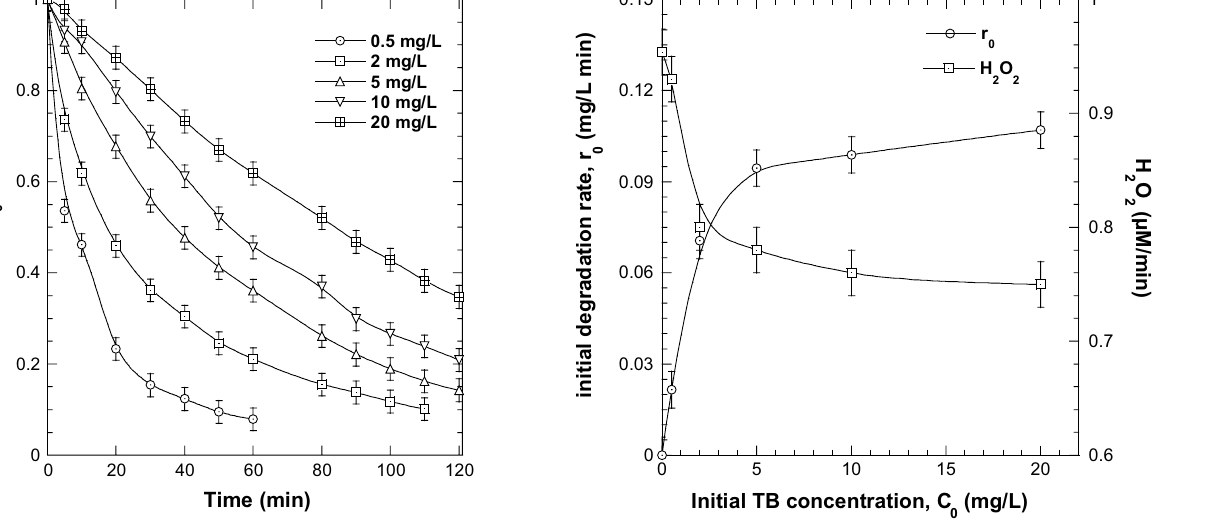
Fig. 7 Initial degradation rate and H 2 O 2 formation rate with respect to the initial TB